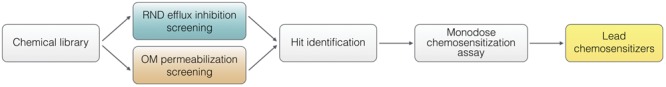
Chemosensitizer discovery workflow.